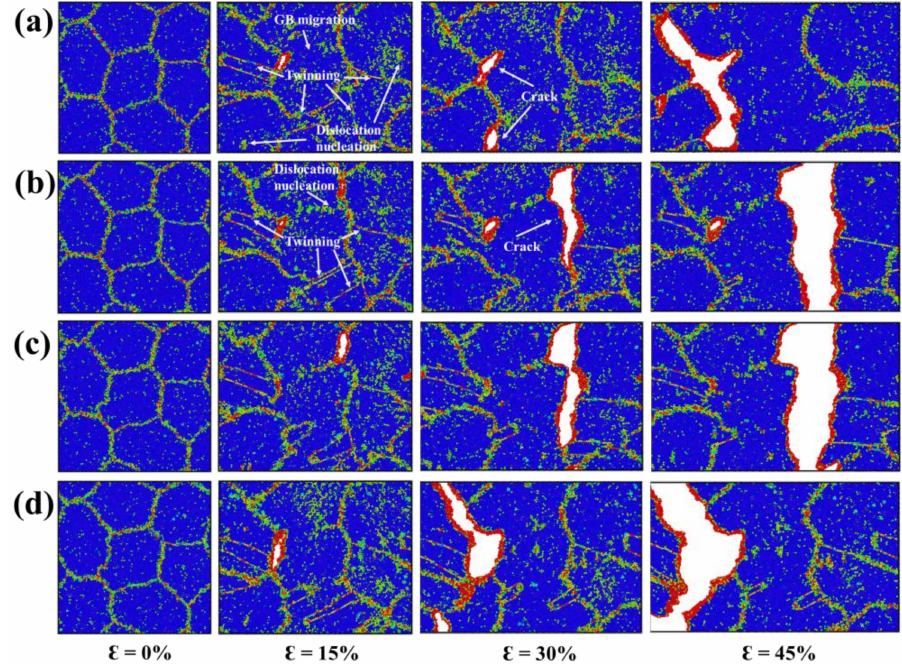
Figure 7. ( a – d ) The atomic snapshots of NG 10 at 0%, 15%, 30% and 45% tensile strains with bulk H concentrations of 0%, 0.25%, 0.5%, 0.75% and 1%,